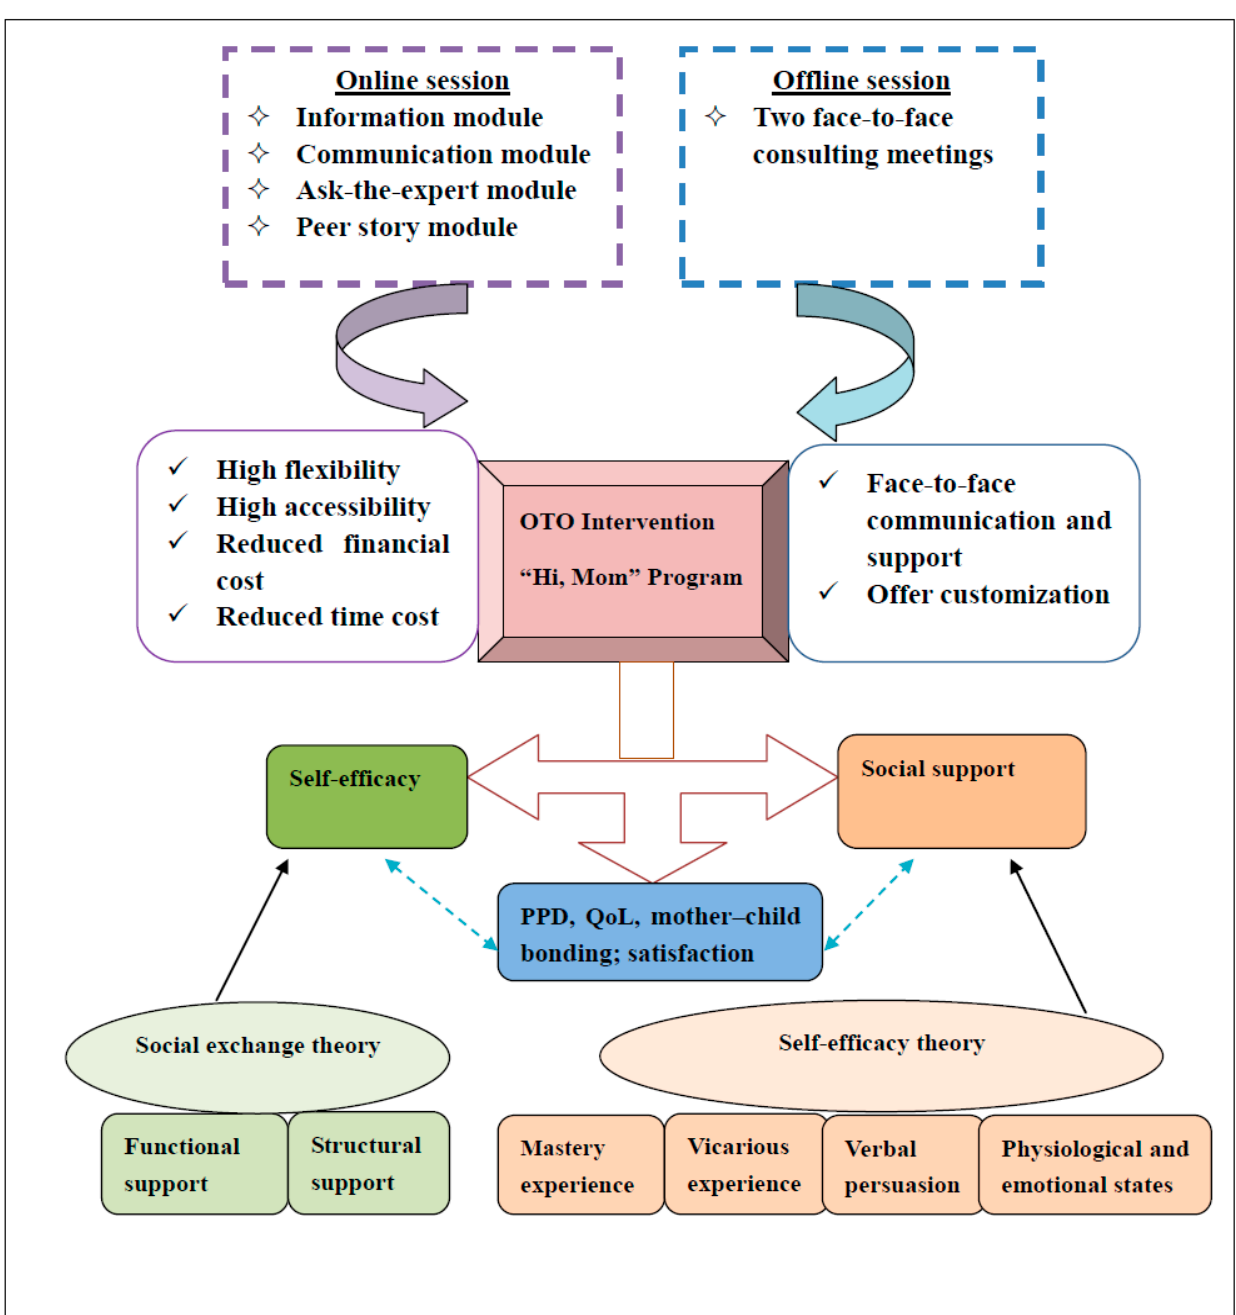
Figure 2. The theoretical framework of the “Hi, Mom” intervention. The women in the control group will receive routine care, including health care from obstetricians and obstetric nurses during the hospitalization of three to five days; and at least two home visits from community health professionals [54]. The women in the intervention group will receive an OTO intervention called the “Hi, Mom” program and routine postpartum care. Table 1 describes the details of the “Hi, Mom”